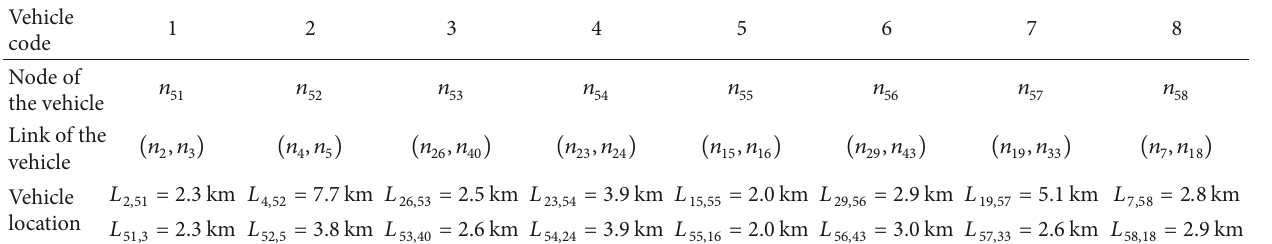
Table 2: Emergency vehicle